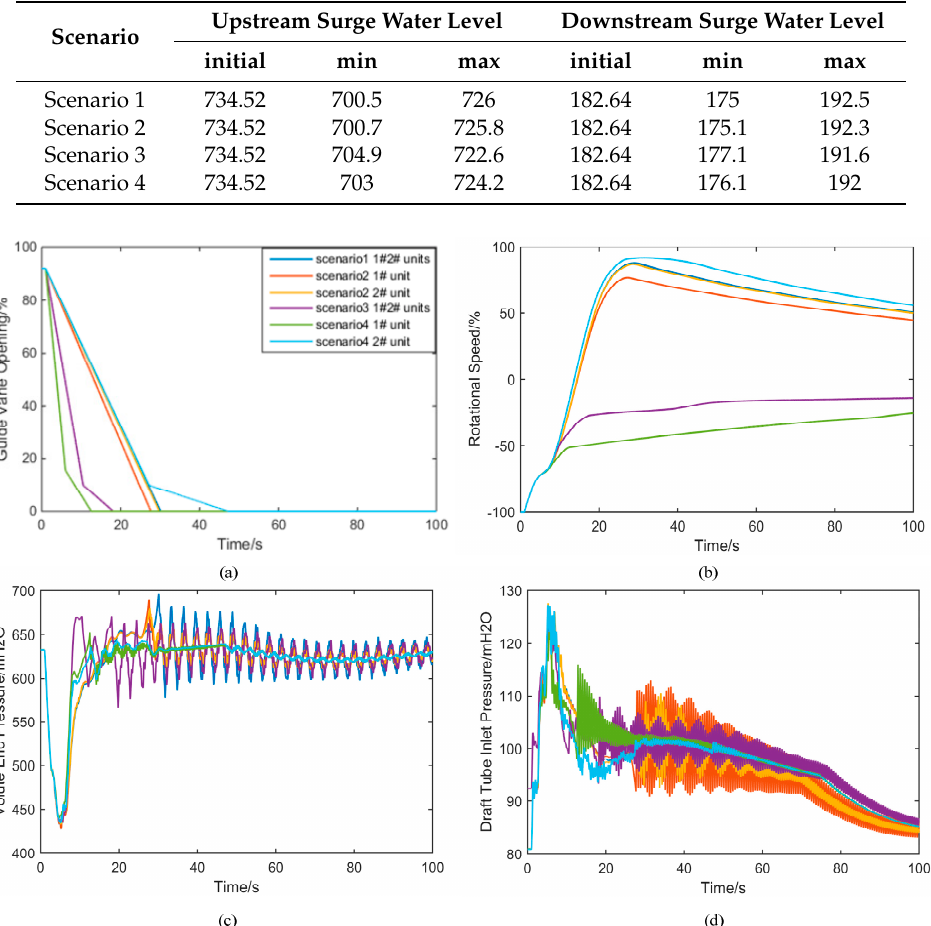
Figure 12. The transient process of 15 schemes by different scenarios: ( a ) guide vane closing laws; ( b ) rotational speed; ( c ) volute end pressure and ( d ) draft tube inlet pressure.